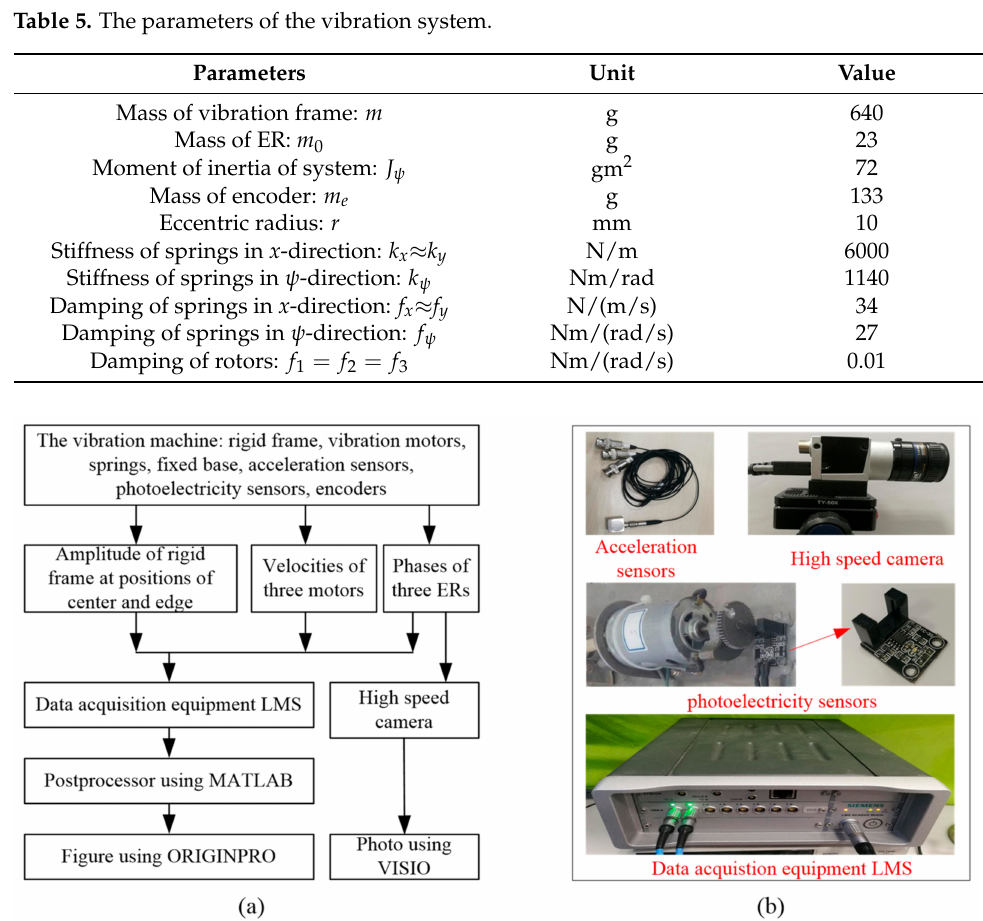
Table 5. The parameters of the vibration system.